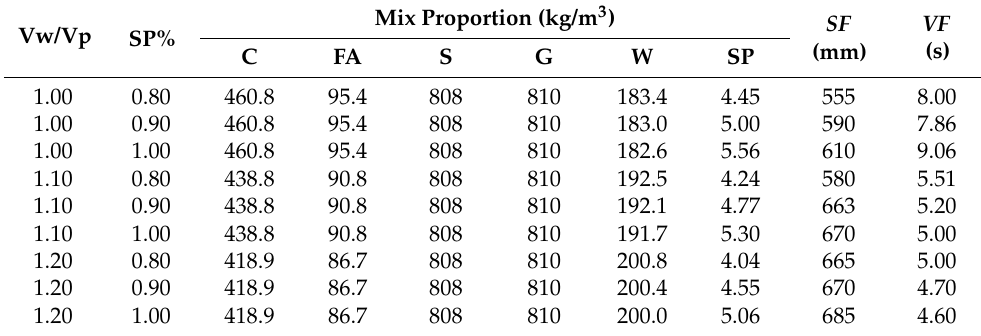
Table 7. Mix proportions and test results of SCC in series